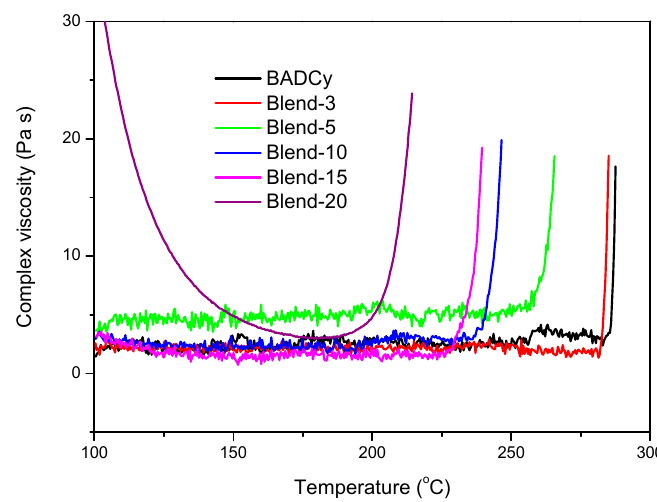
Figure 2. The viscosity–temperature profiles of BADCy and TPI / BADCy blends. Table 1. Cure of BADCy and TPI / BADCy blends.